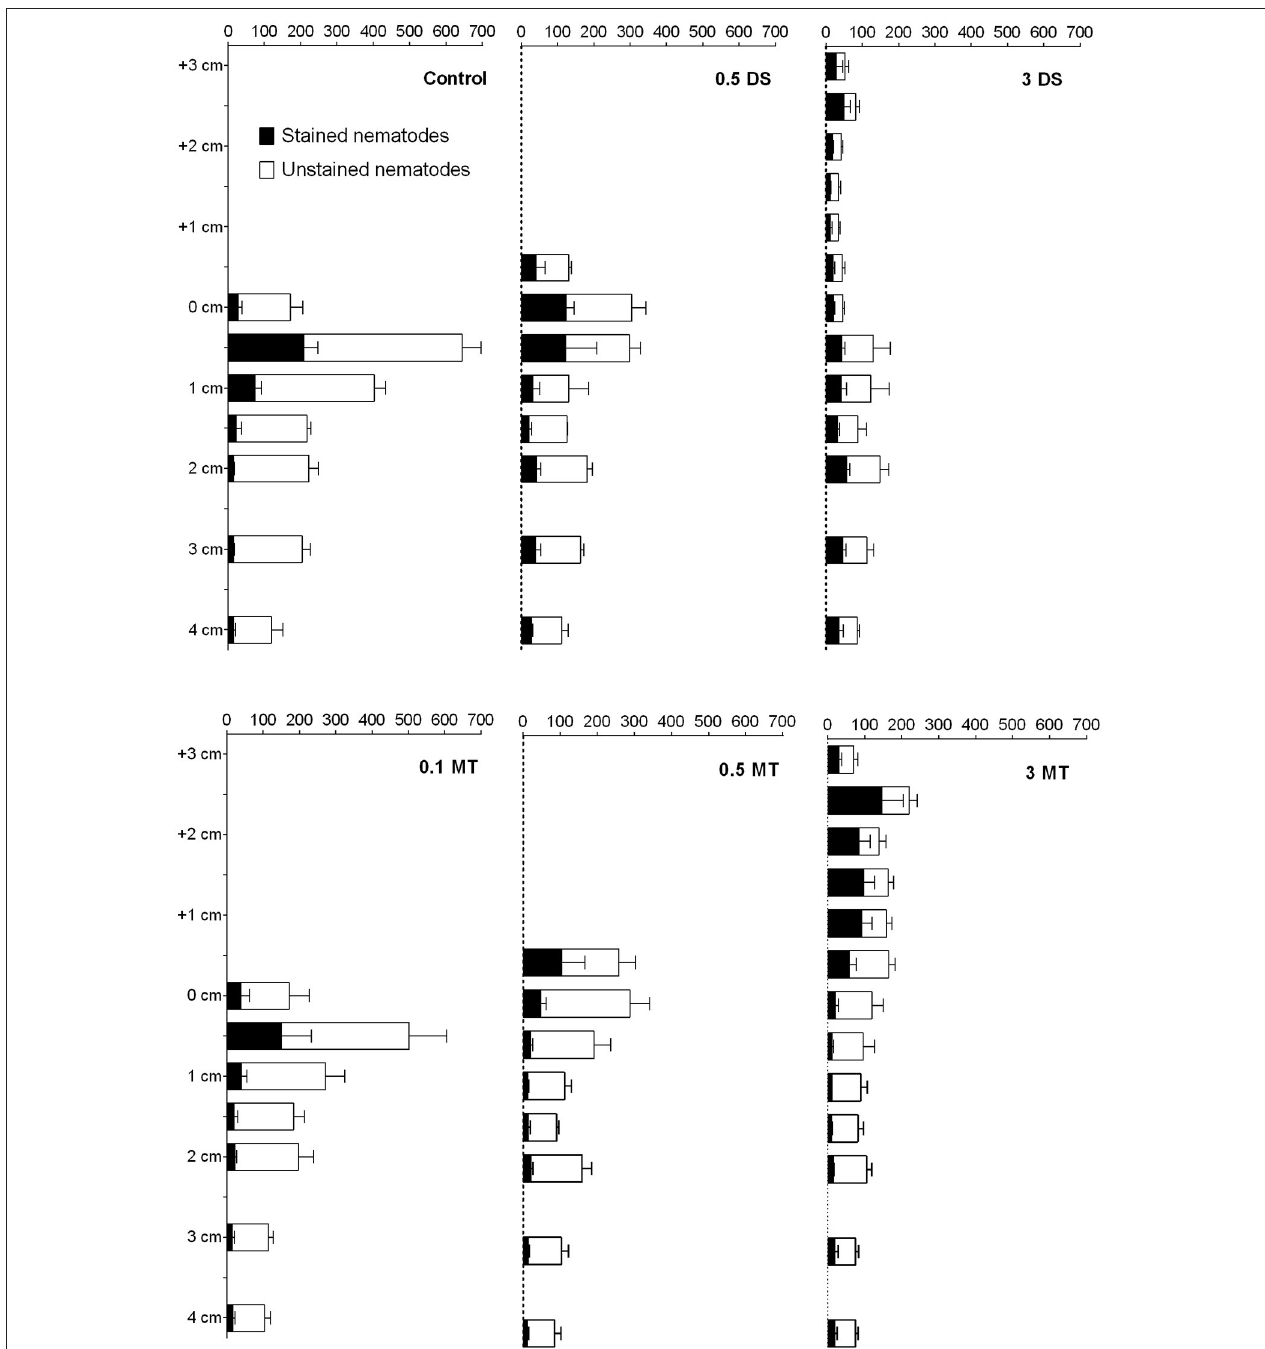
FIGURE 4 | Mean abundances (x-axis) of stained (dead) and unstained (alive) nematodes in the different substrate addition treatments. Error bars indicate standard error. Abbreviations: 0.1 MT = 0.1cm mine tailing addition, 0.5 MT = 0.5cm mine tailing addition, 3 MT = 3cm mine tailing addition, 0.5 DS = 0.5cm dead sediment addition, 3 DS = 3cm dead sediment